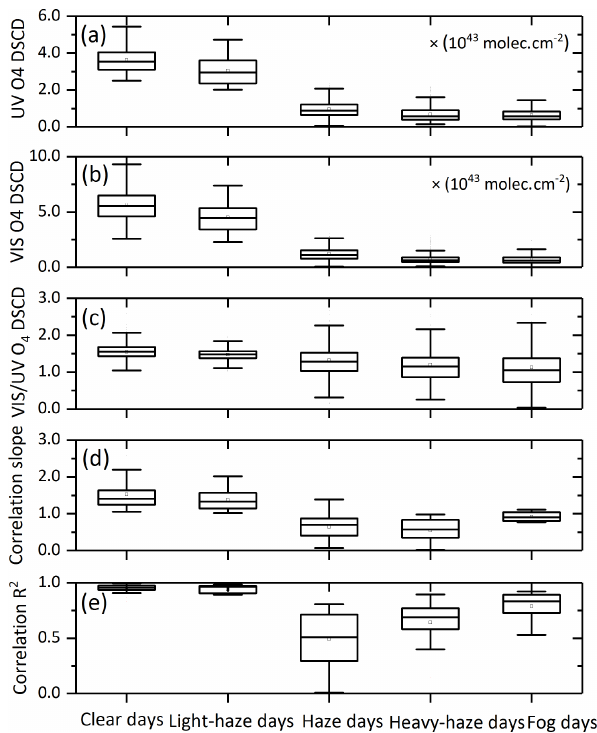
Figure 5. Box plots of statistics for the O 4 DSCD under dif- ferent weather conditions: (a) in the UV band, (b) in the visi- ble band, (c) the ratio of visible / UV O 4 DSCD, (d) correlation slope, and (e) R 2 between the UV and visible ranges (visible O 4 DSCD = slope · UV O 4 DSCD +